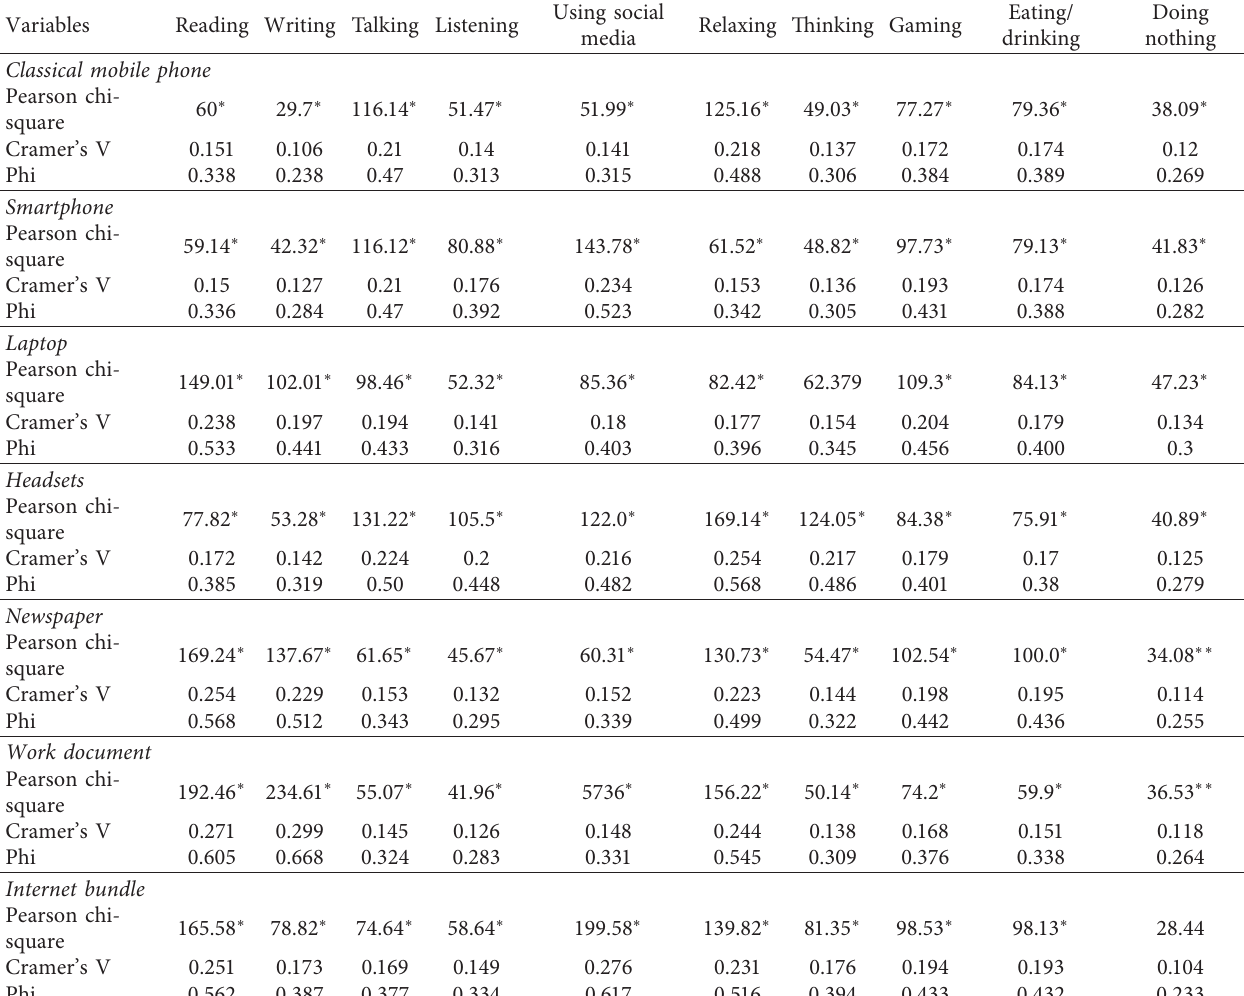
Table 5: The chi-square test and the symmetric measures of the tools carried by travelers and the onboard activities. Variables Reading Writing Talking Listening